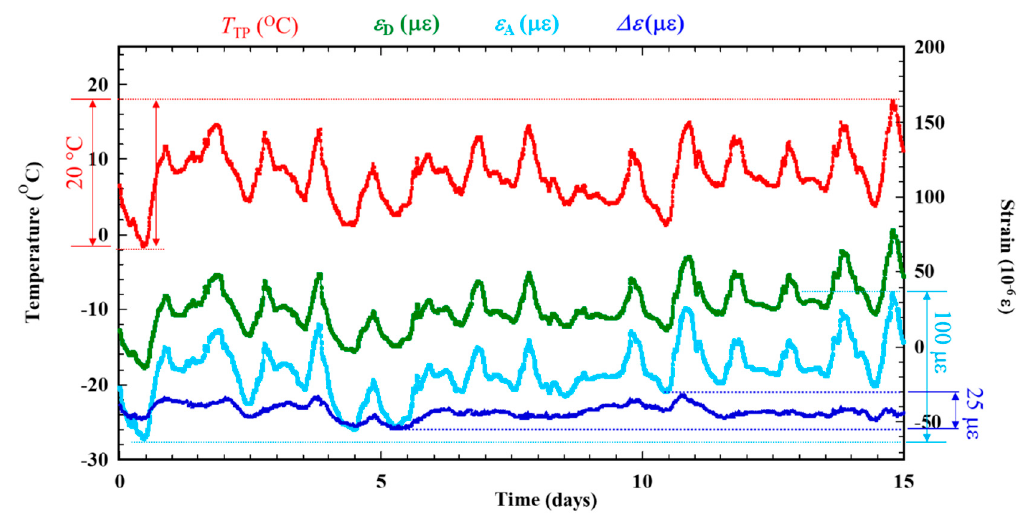
Figure 6. Compensation of thermal strain experiment signal ( T TP ) before under dry-wet condition are applied.